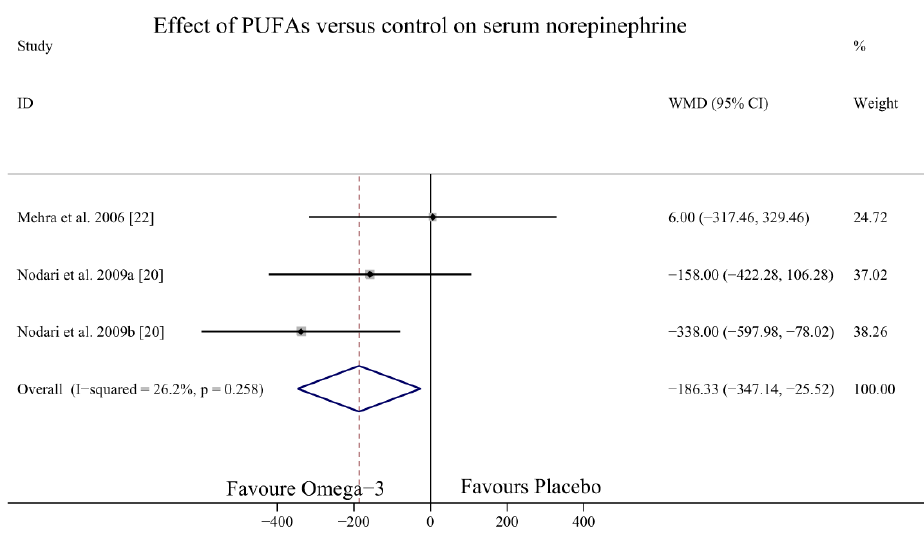
Figure 9. Forest plot depicting the effect of omega-3 PUFAs on SNE level (WMD, weighted mean difference). Abbreviations: PUFAs, polyunsaturated fatty acids; SNE, serum norepinephrine.